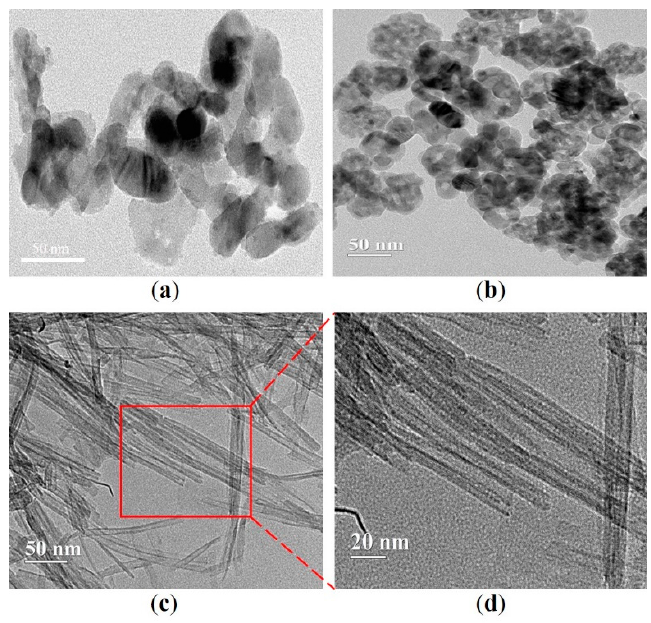
Figure 5. Morphology of ( a ) m-TiO2, ( b ) n-TiO2, and ( c ) TNT. ( d ) Higher magnification image of TNT.